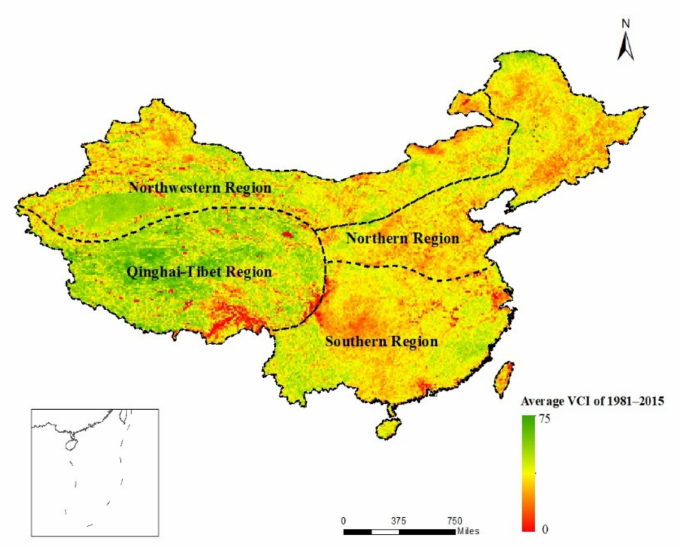
Figure 1. Four geographical regions of China. The background is the average VCI value of